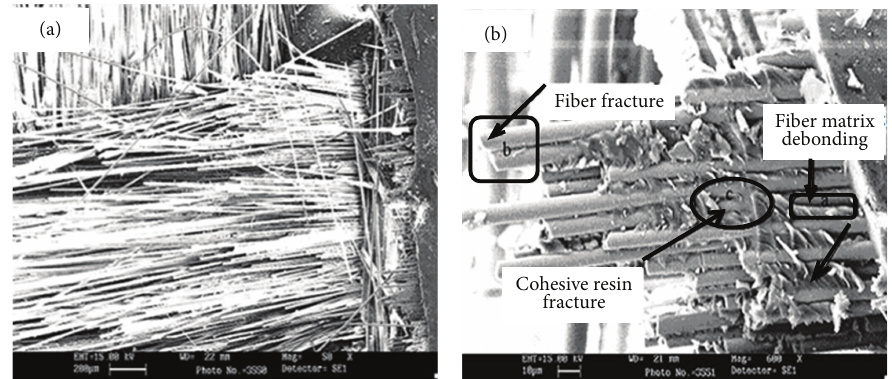
Figure 8: SEM pictures of tensile fractured surfaces of unfilled G-E composites.